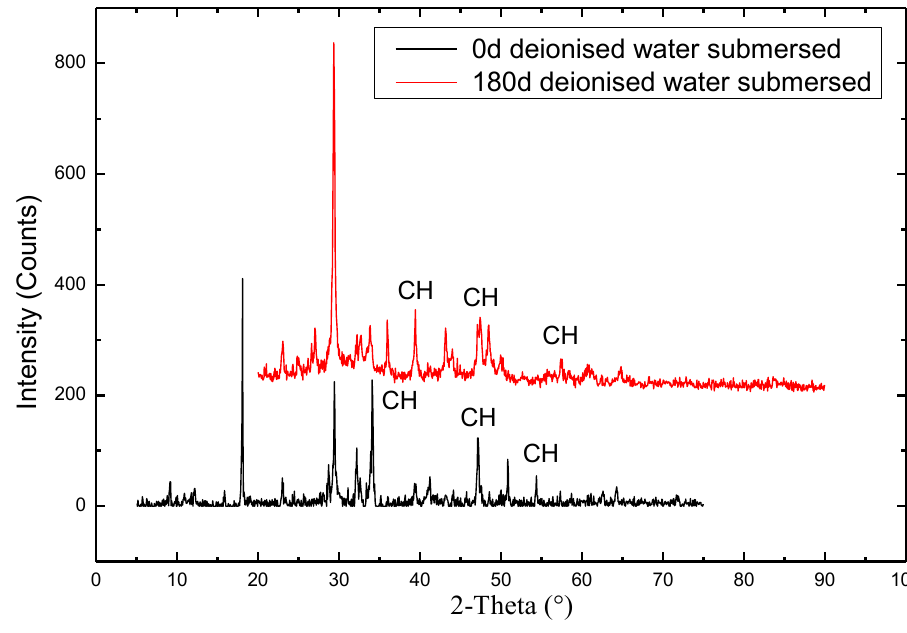
Figure 2. X-ray diffraction (XRD) patterns of Ordinary Portland Cement (OPC) at the submersion ages of 0 and 180